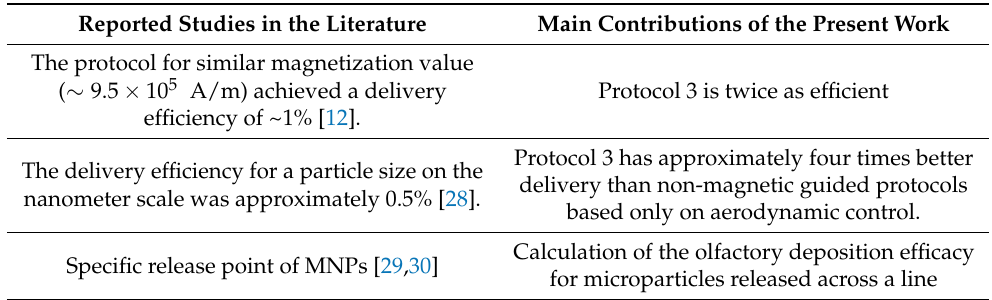
Figure 6. Distance from the outside nose septum to the nasal septum in human geometry. This distance of approximately 5 mm (blue line) was used as the distance of the magnets from the nasal geometric volume for the numerical analysis. Table 3. Comparison of the main contributions of the work vs. those reported in the state of the